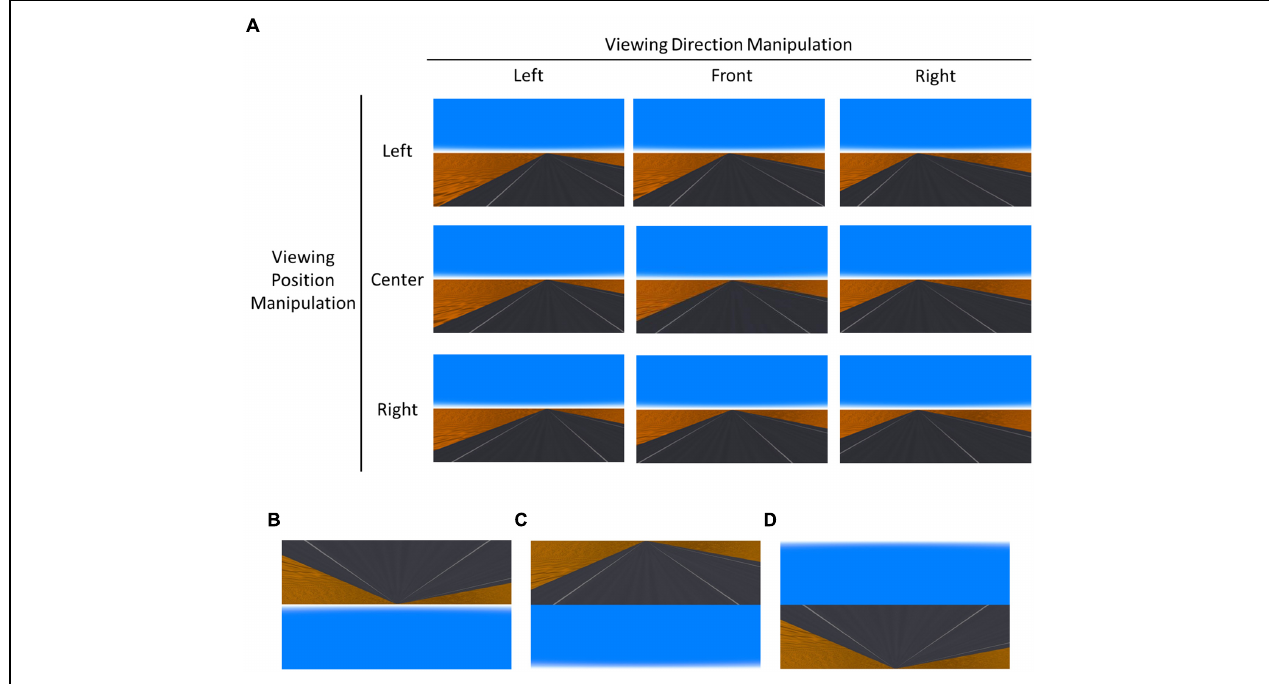
FIGURE 1 | Examples of stimuli in the experiments. (A) Nine types of image in the normal image condition: three viewing direction manipulations (left, front, and right) × 3 viewing position manipulations (left, center, and right). In the front direction detection task, presented images were chosen from one row. In the center position detection task, presented images were chosen from one column. (B) An example of the inverted images used in Experiment 1. (C) An example of the transposed images used in Experiment 2. (D) An example of the inverted and transposed images used in Experiment 3.